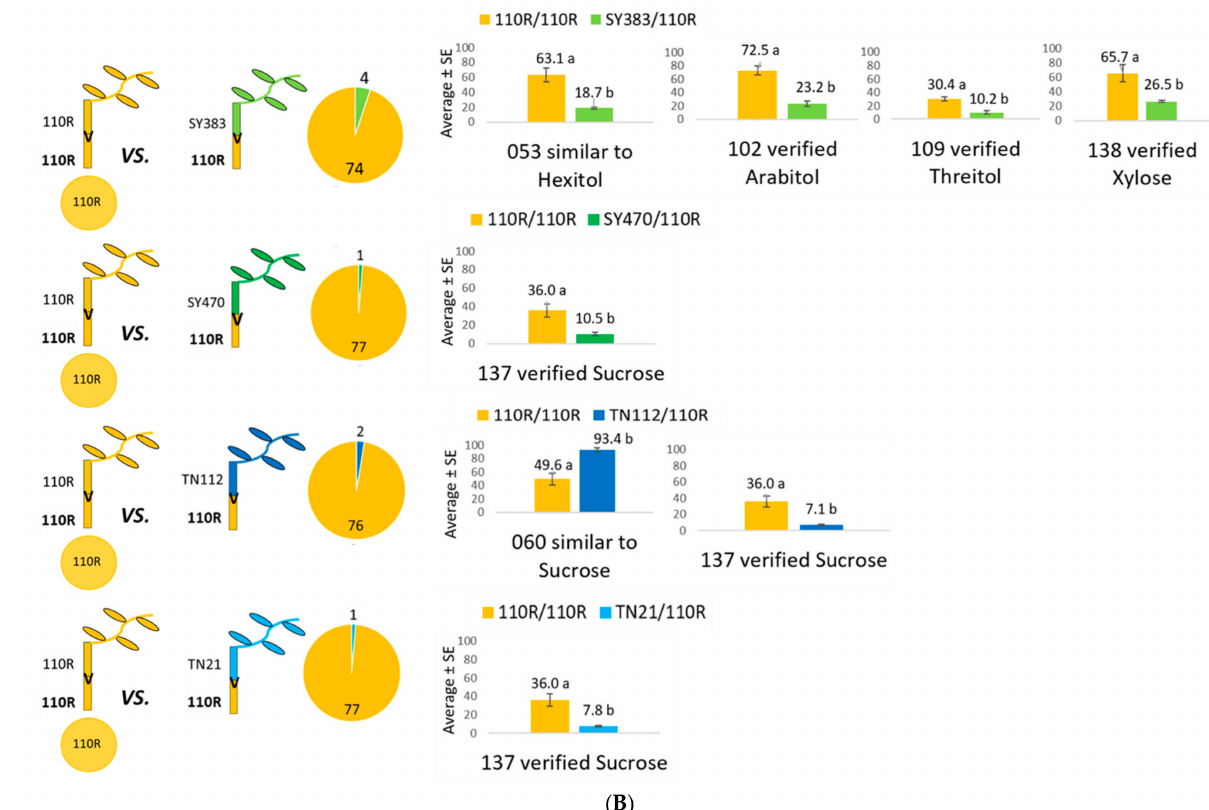
Figure 3. Scale of the effect and significant different metabolites: ( A ) in the leaves ; ( B ) the rootstock phloem exudate ’ samples of homografts upon grafting with a heterologous partner. Scale of the effect of a heterologous grafting partner in the leaves and phloem rootstocks’ metabolome of a homograft and pie graphs with the number of changed and unchanged metabolites (left); bar charts of the mean value of significant different metabolites upon grafting with a heterologous partner (right). The different letters indicate significant differences between the graft combinations at p < 0.05 according to the Tukey post hoc test. Data are presented as the average of data normalized to the maximum value for each metabolite. Bars represent the standard